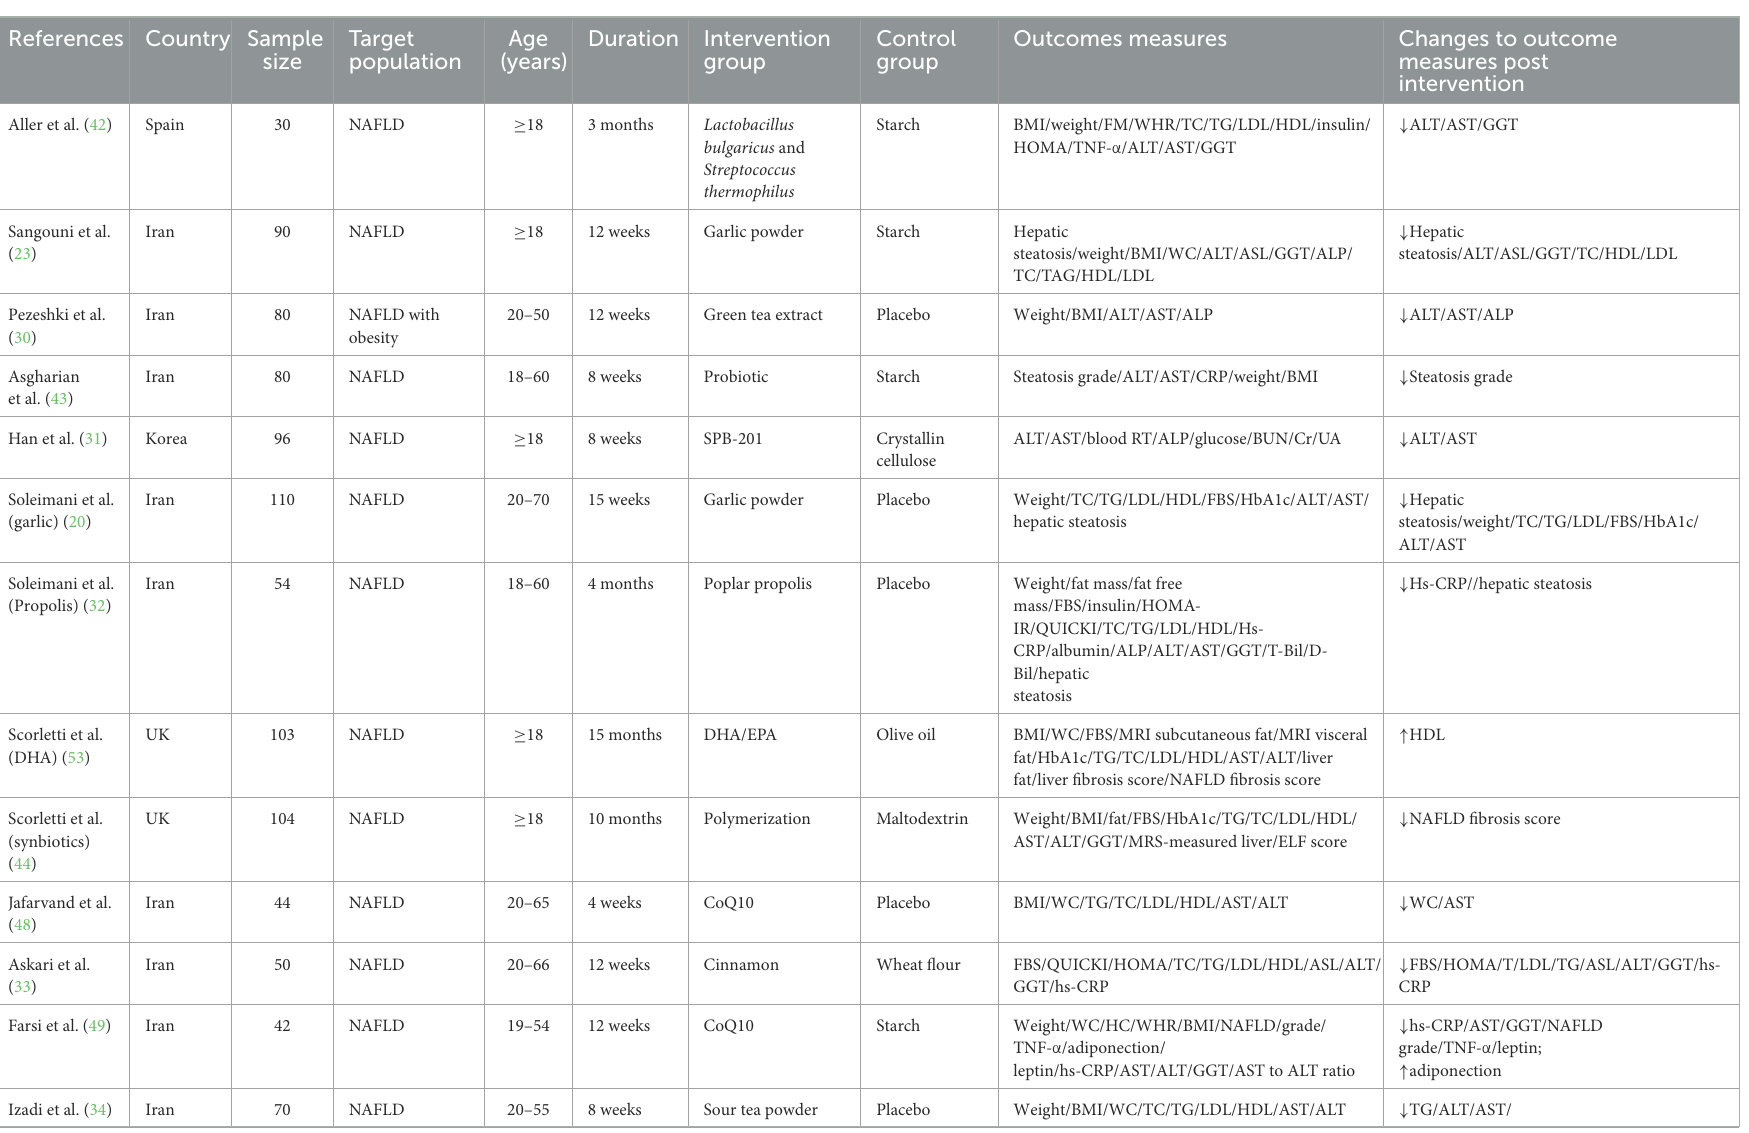
TABLE 1 Characteristics of included